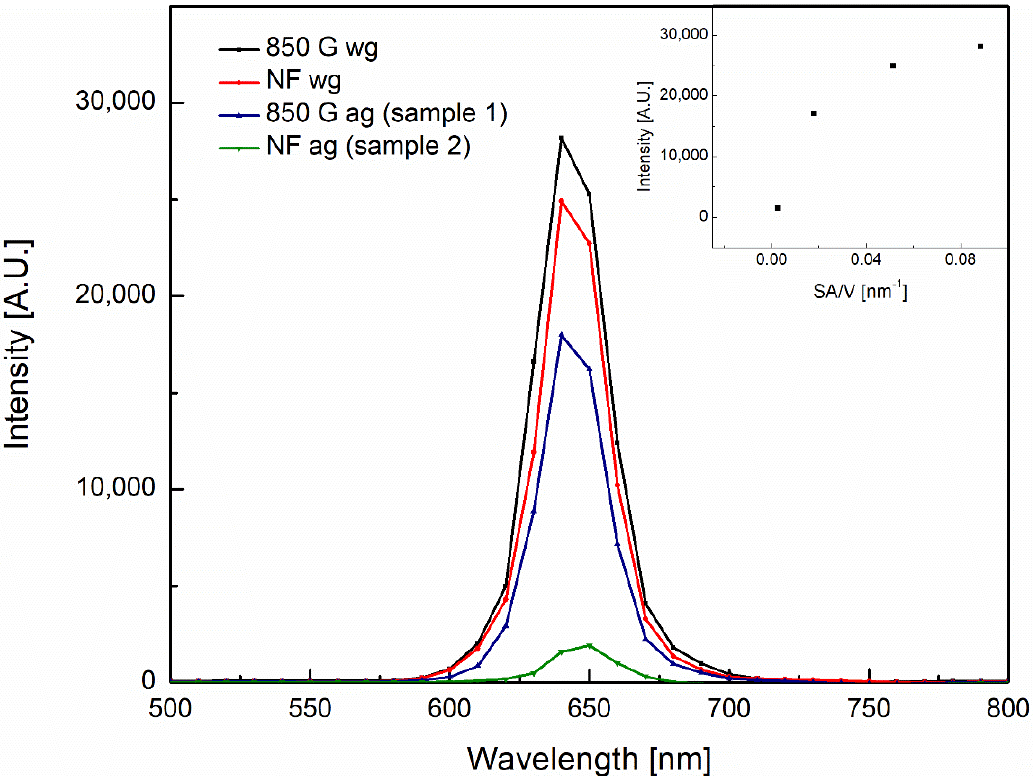
Figure 3. PL of different morphologies of ZnO rods. 850 G applied field wg, the smallest rods, have the greatest intensity; NF ag, the largest rods, have the smallest intensity. The inset shows the maximum intensity versus the surface area to volume ratio on the x axis.